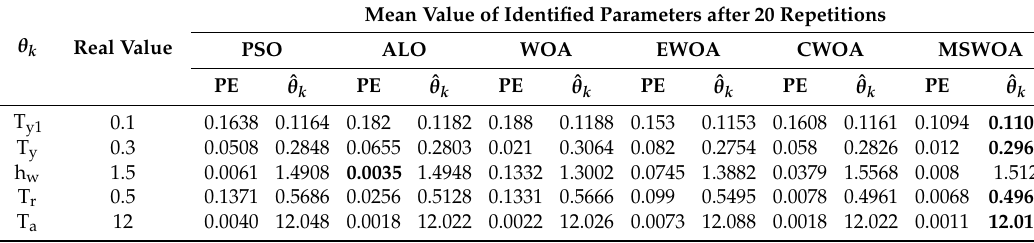
Table 10. Mean identified parameters under no-load